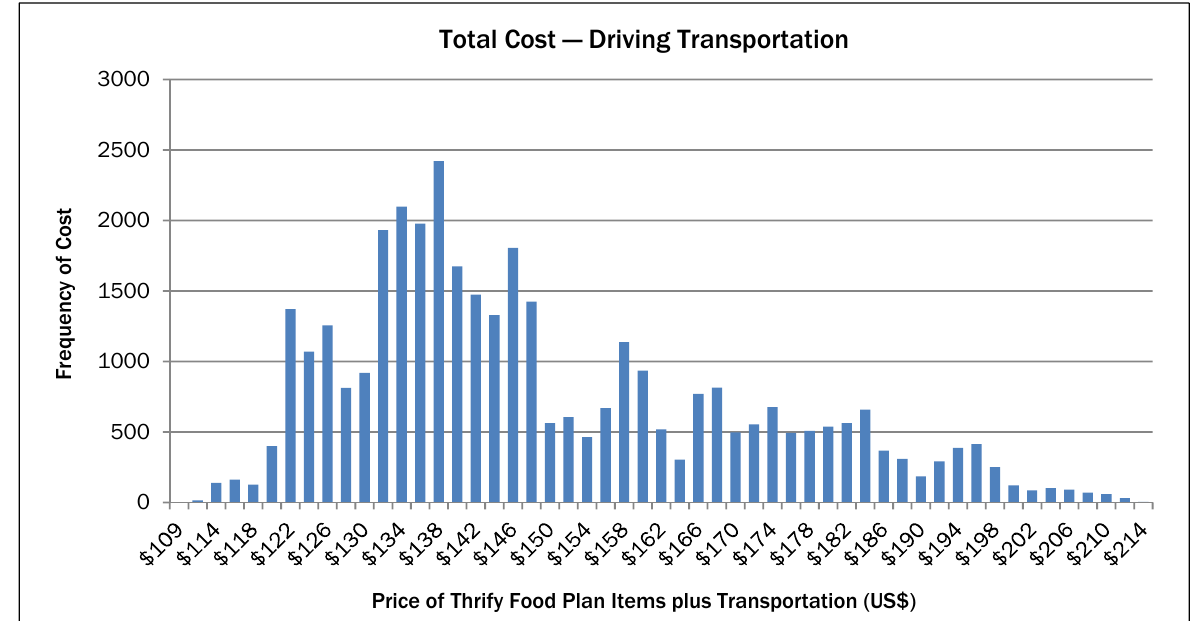
Figure 2. Variation in total cost of the USDA Thrifty Food Plan in the Gulf Coast counties of Mississippi, during spring 2011, assuming that all items are purchased and the shopper uses an automobile for transportation and achieves the lowest cost for the combination of food price and